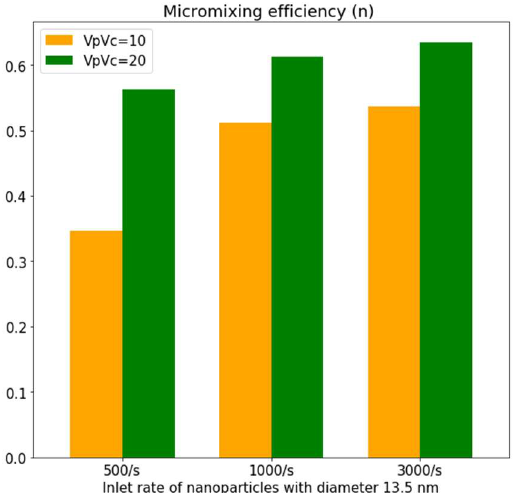
Figure 4. Mixing efficiency for V p /V c = 10 and V p /V c = 20 under inlet rates equal to 500, 1000, and 3000 nanoparticles per second.